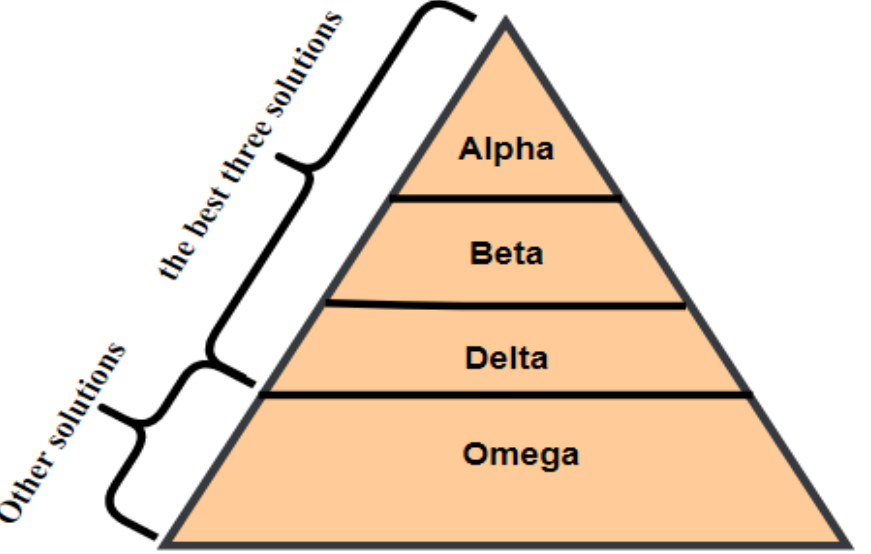
Figure 6. Hierarchy of grey wolves [26,38].